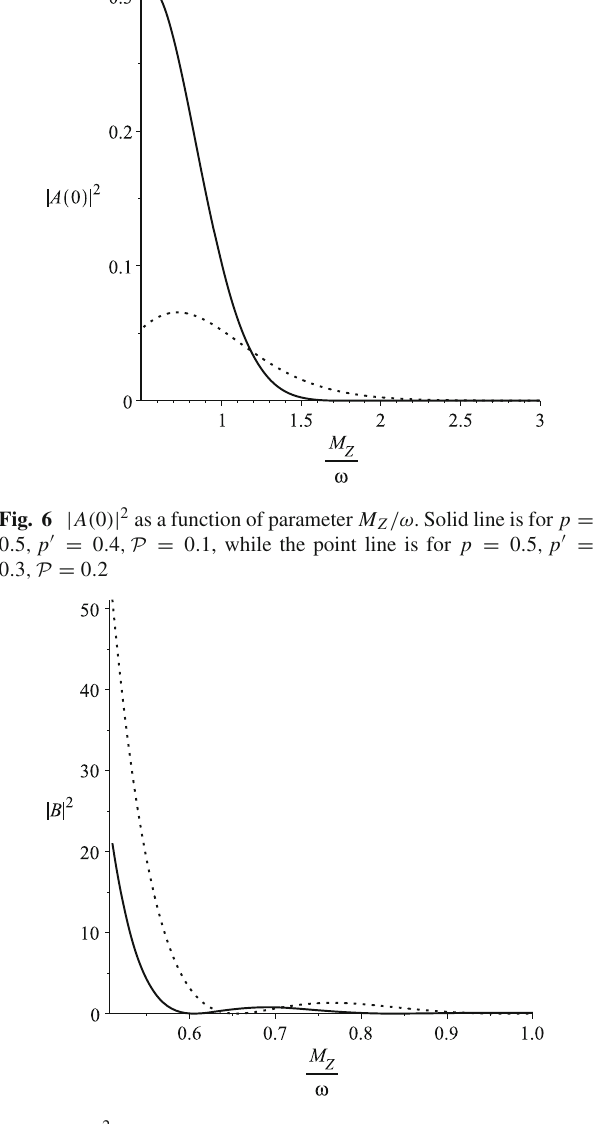
Fig. 7 | B k | 2 as a function of parameter M Z /ω . Solid line is for p = 0 . 5 , p (cid:11) = 0 . 4 , P = 0 . 0001, while the point line is for p = 0 . 2 , p (cid:11) = 0 . 4 , P = 0 . 0004